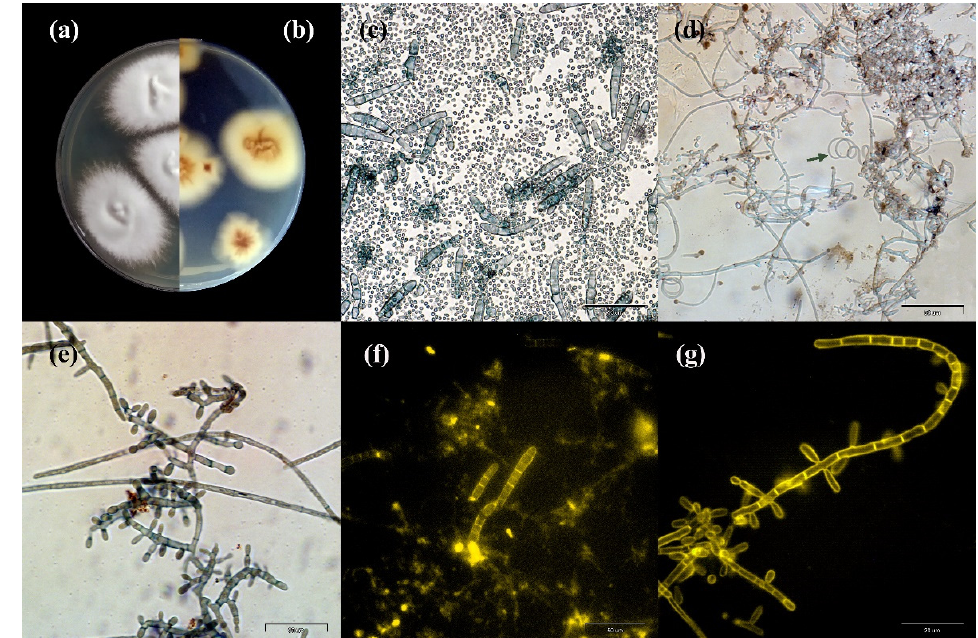
Figure 2. Macro ‐ and micromorphology of Trichophyton quinckeanum isolated from humans and cats: ( a , b ) macromorphology on Sabouraud medium at 28 °C for 14 days: ( a ) obverse; ( b ) reverse; ( c – g ) macro ‐ and microconidia in a 14 ‐ day culture preparation: ( c ) macro ‐ and microconidia stained with chlorazol black E, magnification 400×; ( d ) microconidia, the arrow indicates the presence of a spiral hypha, chlorazol black staining, magnification 400×; ( e ) microconidia, chlorazol black staining, mag ‐ nification 1000×; ( f ) macroconidia, calcofluor white fluorescent staining, magnification 400×; ( g ) mi ‐ croconidia, calcofluor white fluorescent staining, magnification 1000×.